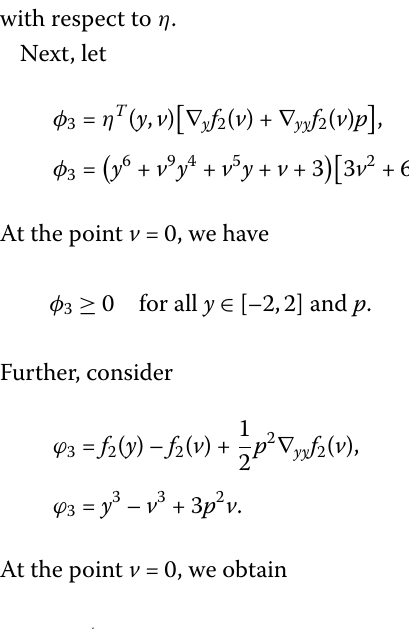
Hence from the expressions φ i and ϕ i , i = 1,2, we get that f is G f -pseudobonvex at v = 0 with respect to η